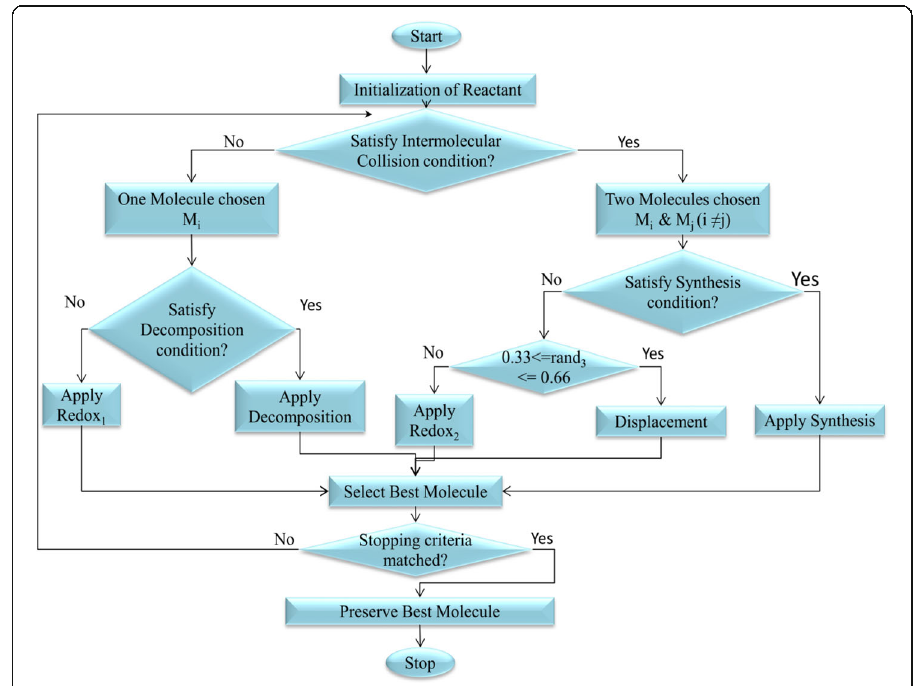
Fig. 1 Chemical reaction optimization